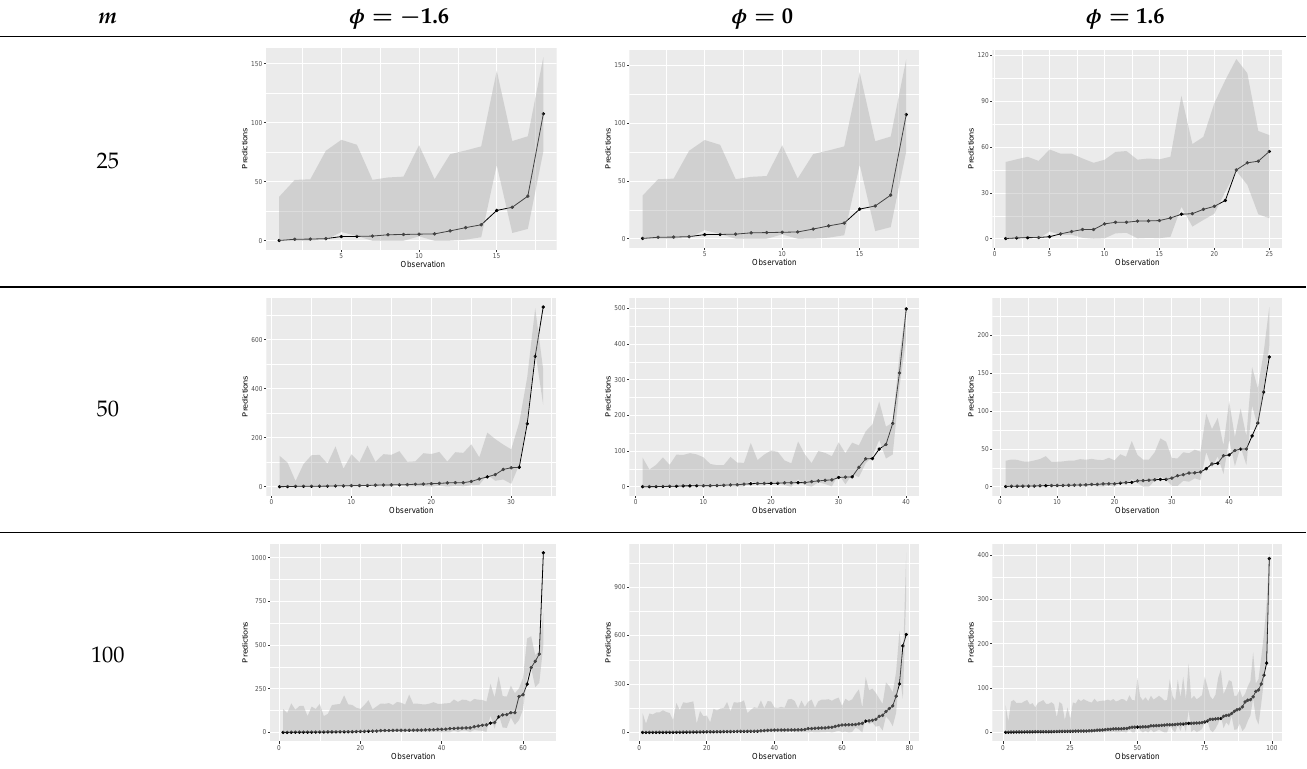
Table 3. Prediction bands of dependent compound regression model for over-, equi- and under- dispersed